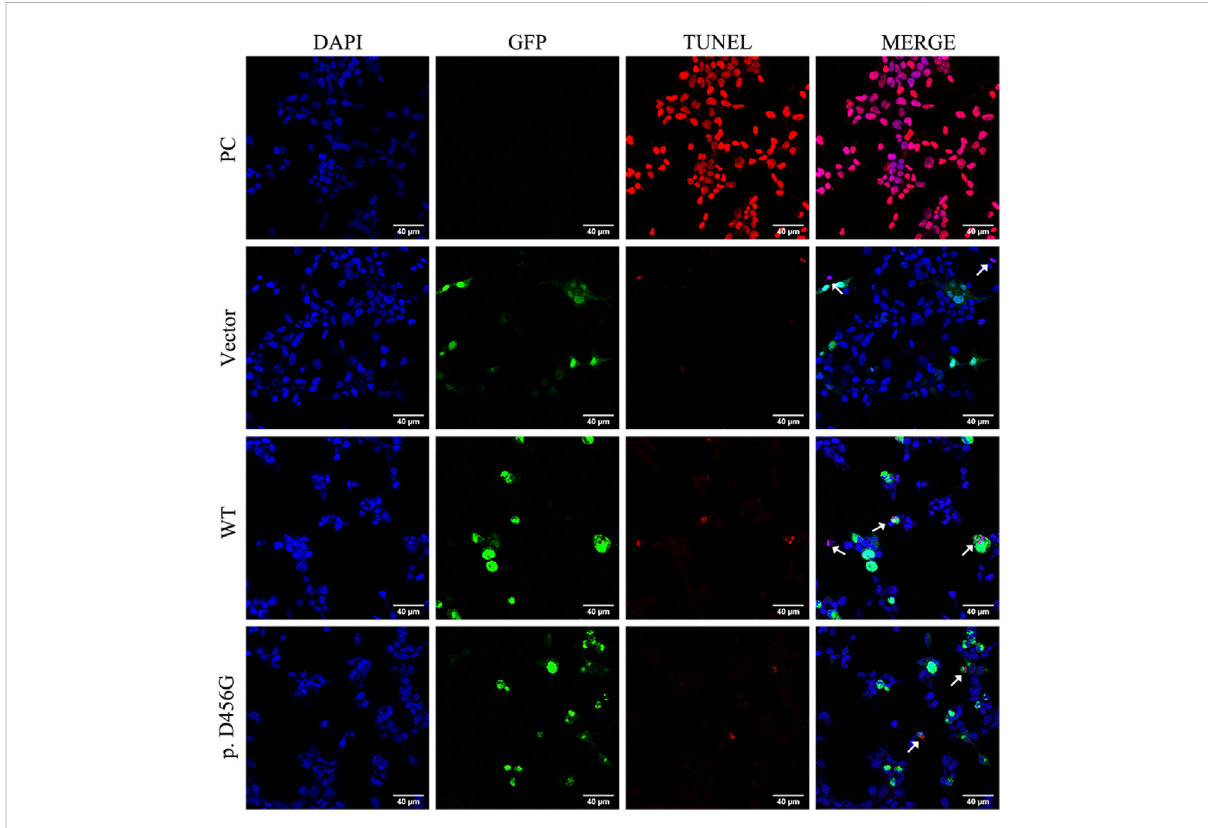
FIGURE 5 Tunelassayofwildtype(WT)andp.D456G AIFM1 proteinsinHEK293cellsshowninTunel,DAPI,GFP-tagged,andmergedimages.PC:positive control. The white arrows indicate the apoptotic